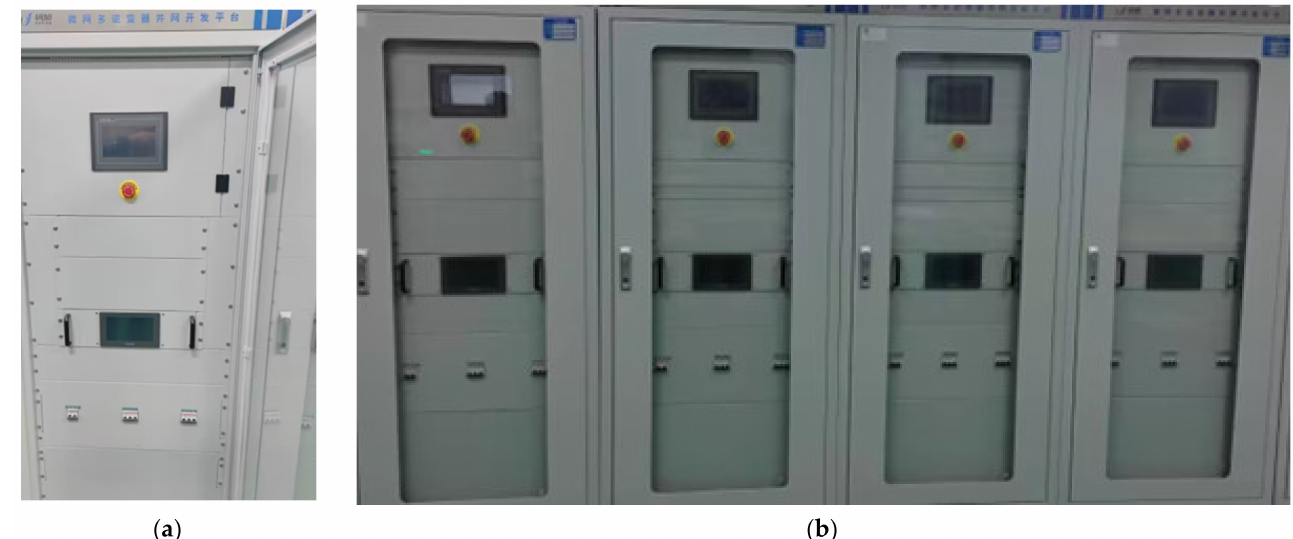
Figure 14. Photo of the prototype. ( a ) Single inverter; ( b ) multiple inverters.